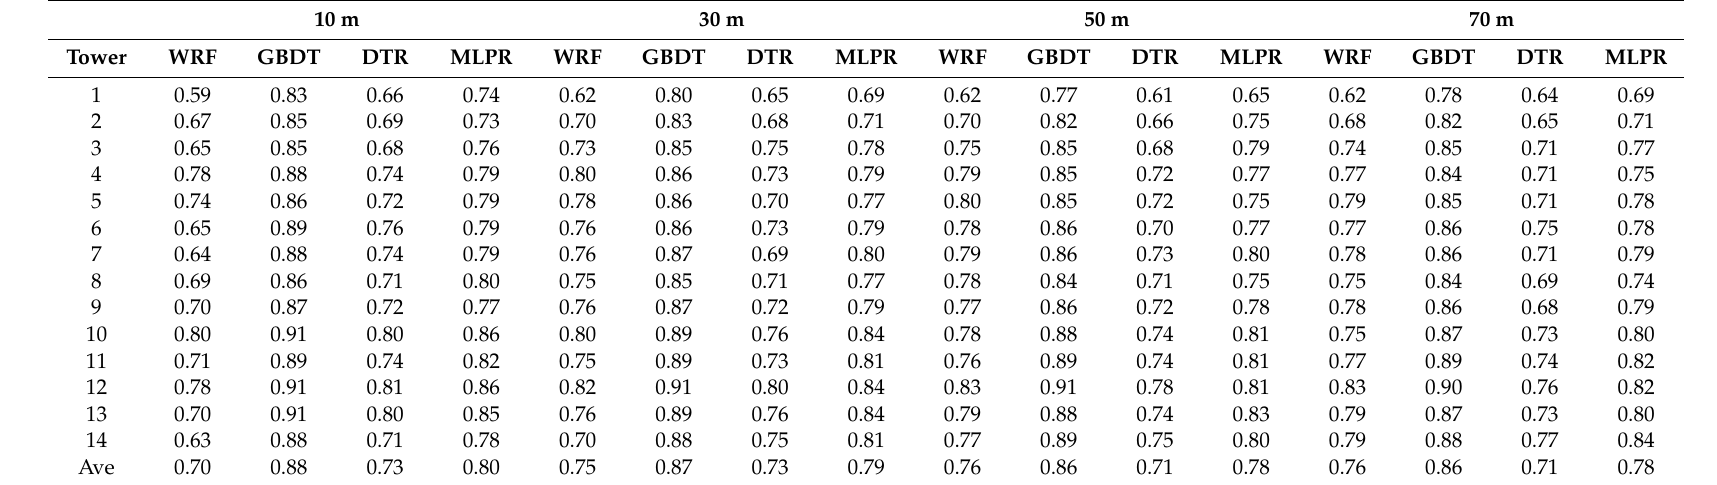
Table A4. The 0–24 h IA of WRF model original output and post-processing model results.